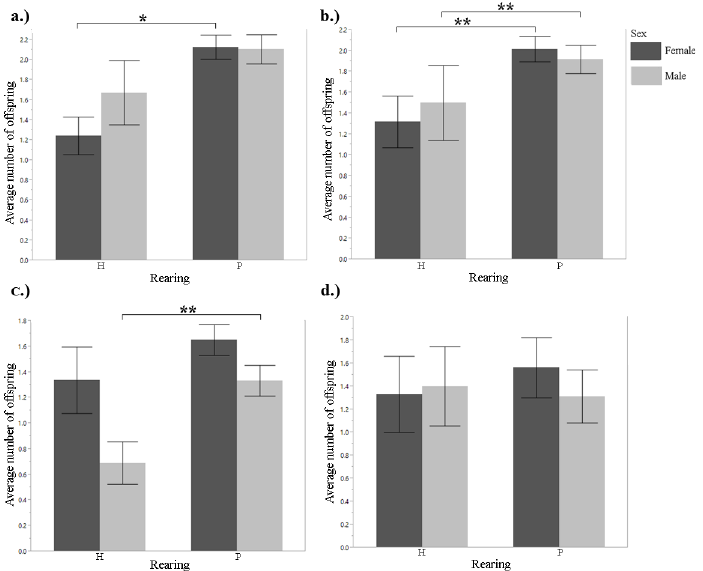
Fig 1. Mean number of offspring a female has birthed or a male has sired during their studbook lifetime, by rearing type (1901 – 2011). A.) Siberian tiger B.) snow leopard C.) cheetah D.) clouded leopard. t-test: * p < 0.05; ** p <